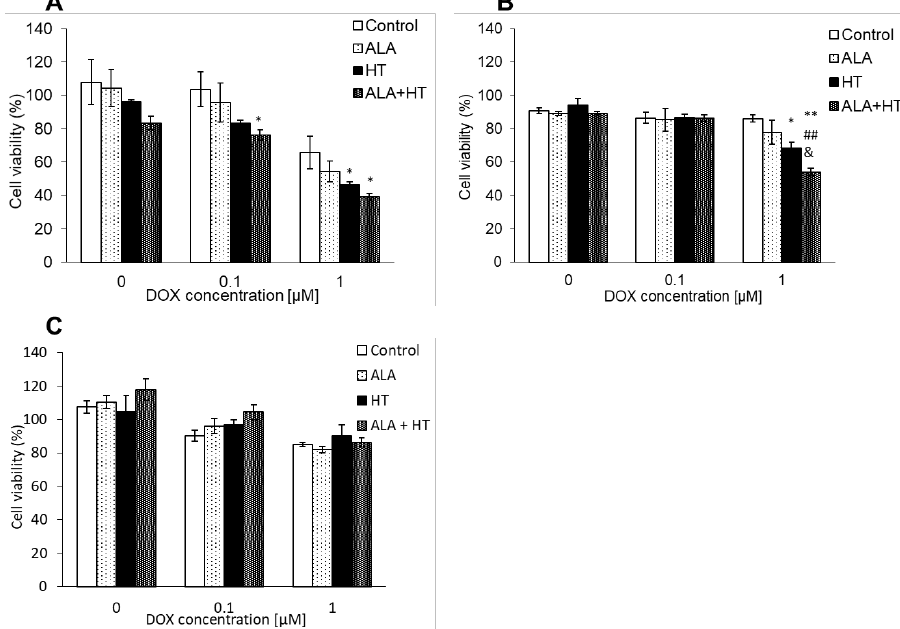
Figure 6. Cytotoxicity effect of DOX. ( A ) 4T1E; ( B ) MBA-MB-231; and ( C ) RGM1 cells. It was enhanced by ALA or HT treatment. ALA+HT treatment most enhanced the cytotoxicity of DOX. Data are expressed as the mean ± SD ( n = 4). * p < 0.05 and ** p < 0.01 vs. Control. ## p < 0.01 vs. ALA. & p < 0.05 vs. HT. Tukey’s post hoc